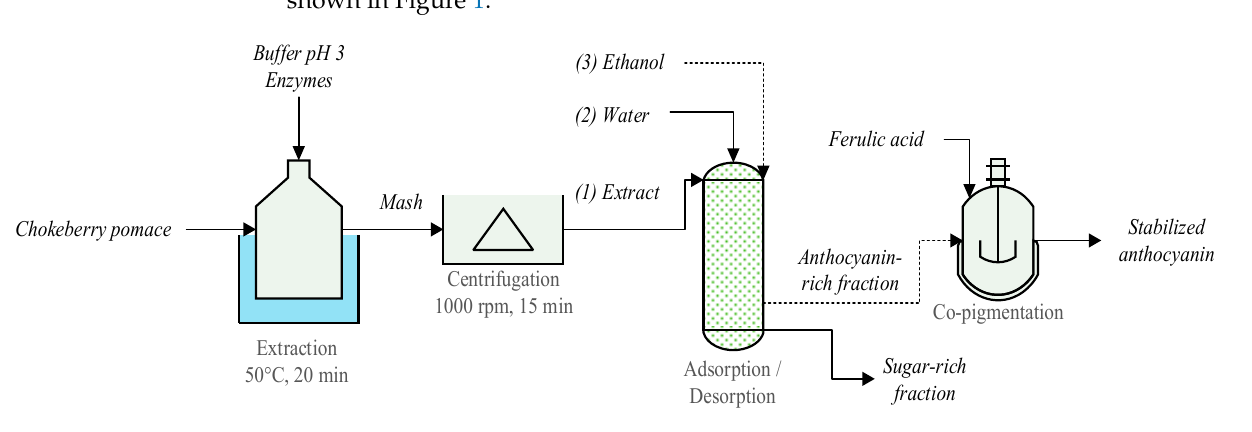
Figure 1. Proposed separation sequence for production of stabilized anthocyanins.